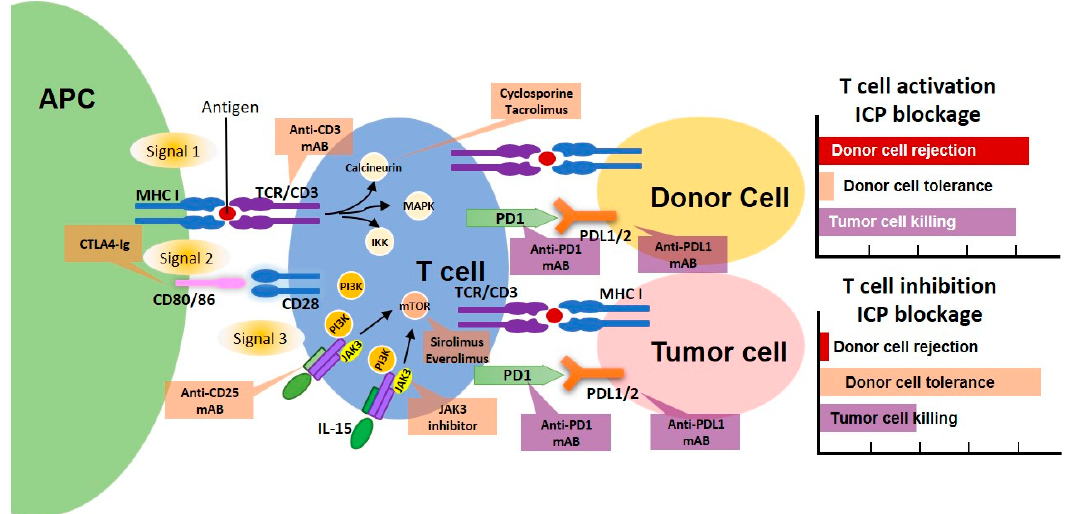
Figure 1. The role of T-cell suppression and immune checkpoint blockage in tumor and organ rejection. Activation of a T cell via 3-signal pathway by an antigen presenting cell (APC) is illustrated. The donor cells are rejected when the T cells are activated. Therefore, the immunosuppressants, which inhibit CD3 (Anti-CD3 mAB), calcineurin (Cyclosporine or Tacrolimus), CD80 / 86 (CTLA4-Ig), IL-2 signaling (Anti-CD25 mAB), JAK3 (JAK3 inhibitor), mammalian target of rapamycin (mTOR) (Sirolimus or Everolimus), and those interfere with the proliferative phase in the cell cycle (MPA, mycophenolate mofetil (MMF), azathioprine, and Fk778; not illustrated) are the key to successful post-